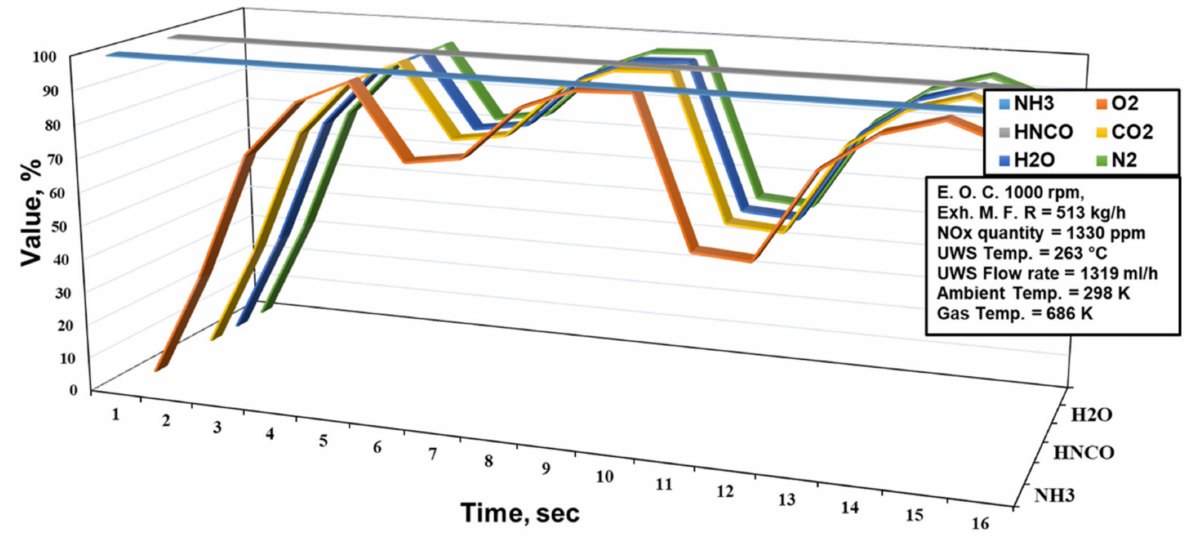
Figure 6. Various gases in the